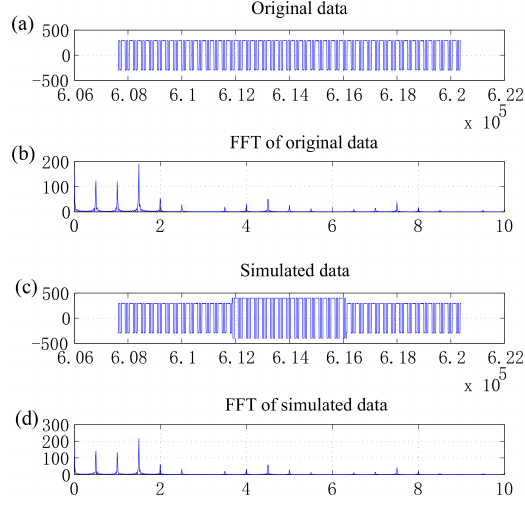
Figure 6. Original data (a, b) and simulated data of amplitude vari- ation (c, d) .